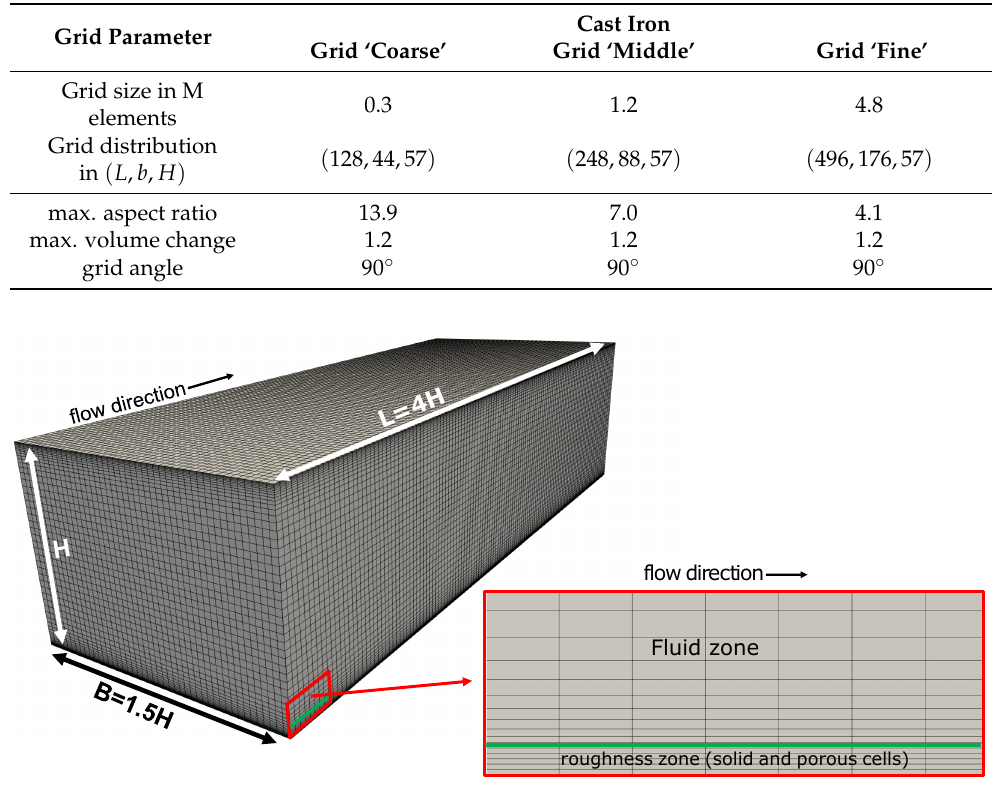
Figure 12. Grid ’coarse’ of the simulation with the cast iron surface in an iso-view and a zoomed, planar view. The fluid and roughness zones are highlighted in the planar